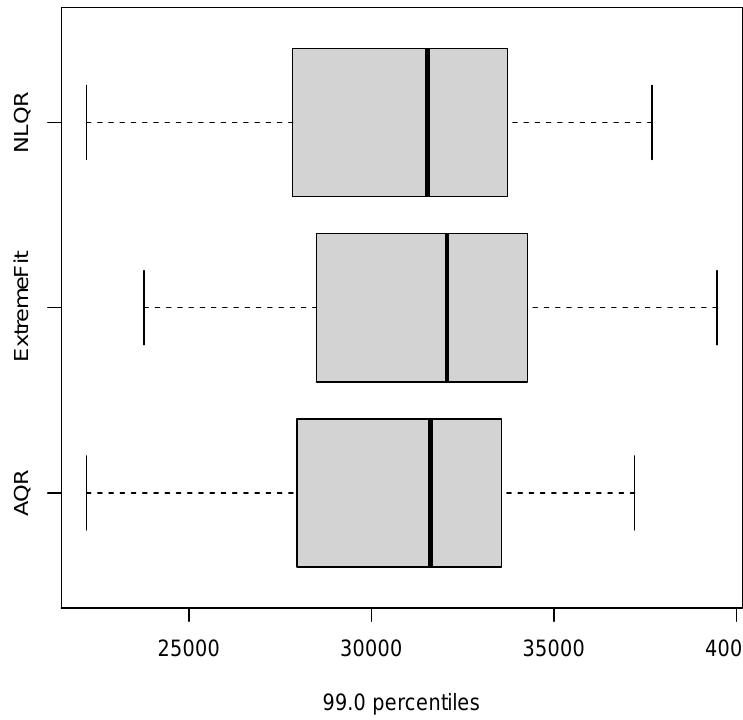
Figure 6. Box plots of the 0.99 quantile.